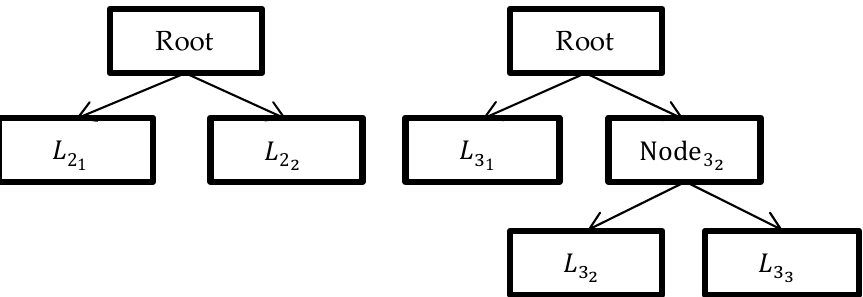
Figure 2. Exemplary tree structures from the two consecutive blocks.